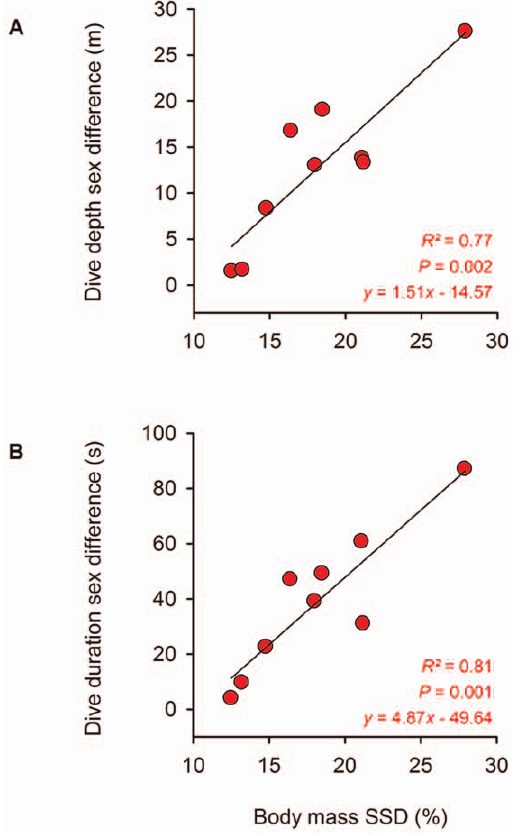
Figure 7. Relationship between SSD and sexual differences in diving capacity in Blue-eyed Shags. Effect of SSD on mean sex difference in (A) dive depth and (B) dive duration for nine study colonies of Blue-eyed Shags. For each colony, mean sex difference in dive capacity is calculated as the difference, between the sexes, in the average of individual